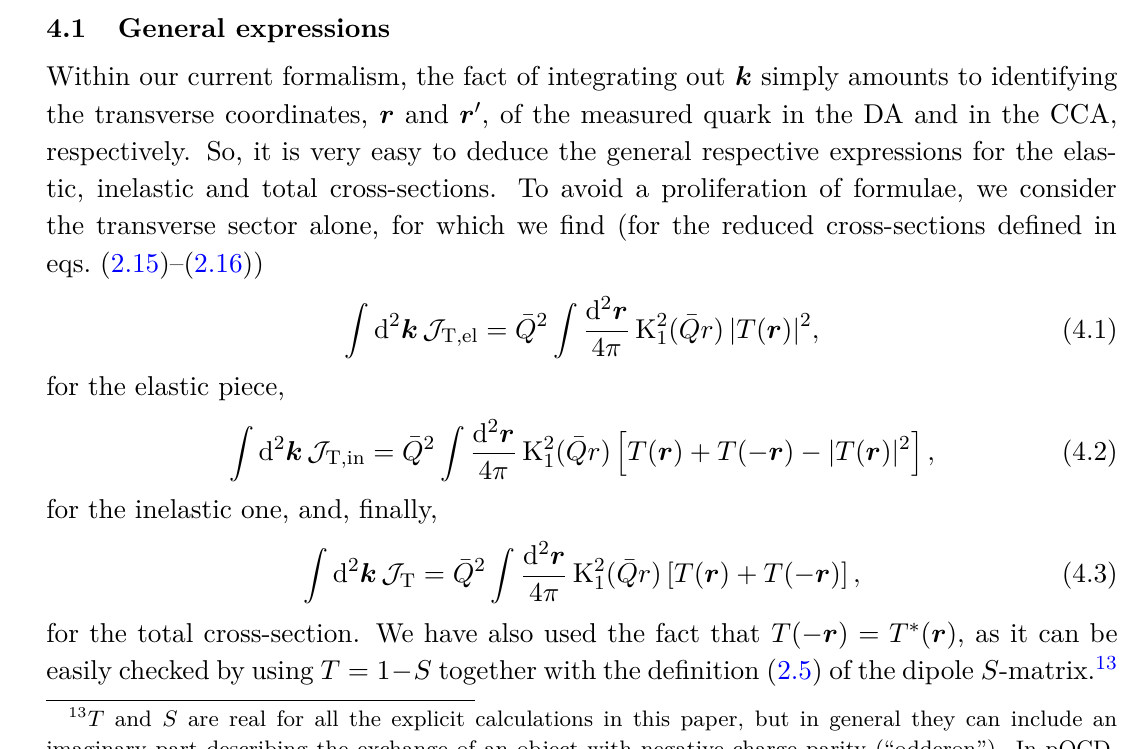
Figure 8. Extension of some of the previous results to larger values of ¯ Q 2 for fixed Q 2 namely ¯ Q 2 /Q 2 = 0 . 25 , 0 . 5 and 1 (within the framework of the MV model). (a) The rescaled s 0 cross-section k 2 J T plotted as a function of k 2 ⊥ as a function of k 2 ⊥